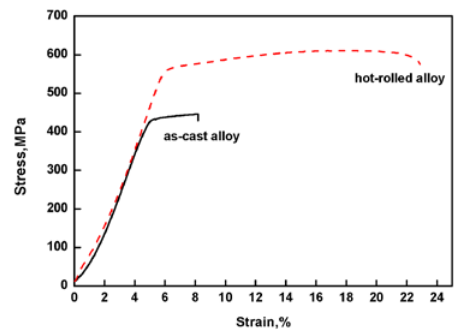
Figure 2. Stress–strain curves of the two alloys tested in air.